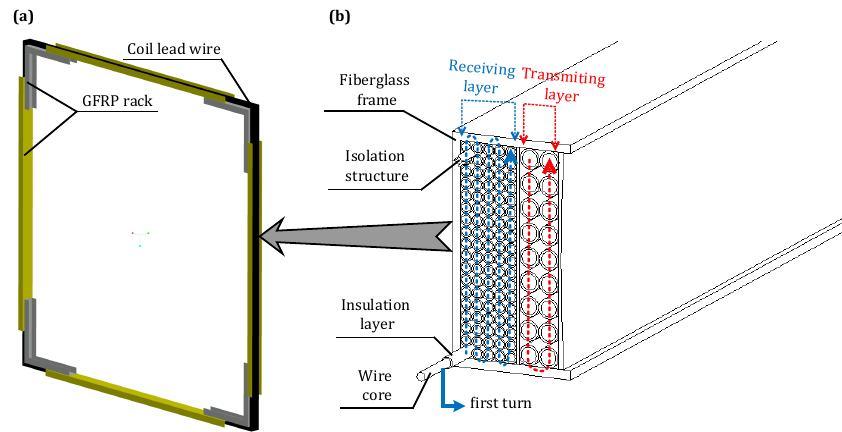
Figure 4. Physical structure diagram of mine meter-scale antenna. ( a ) 2-m stationary detection antenna and bracket; ( b ) antenna internal structure.